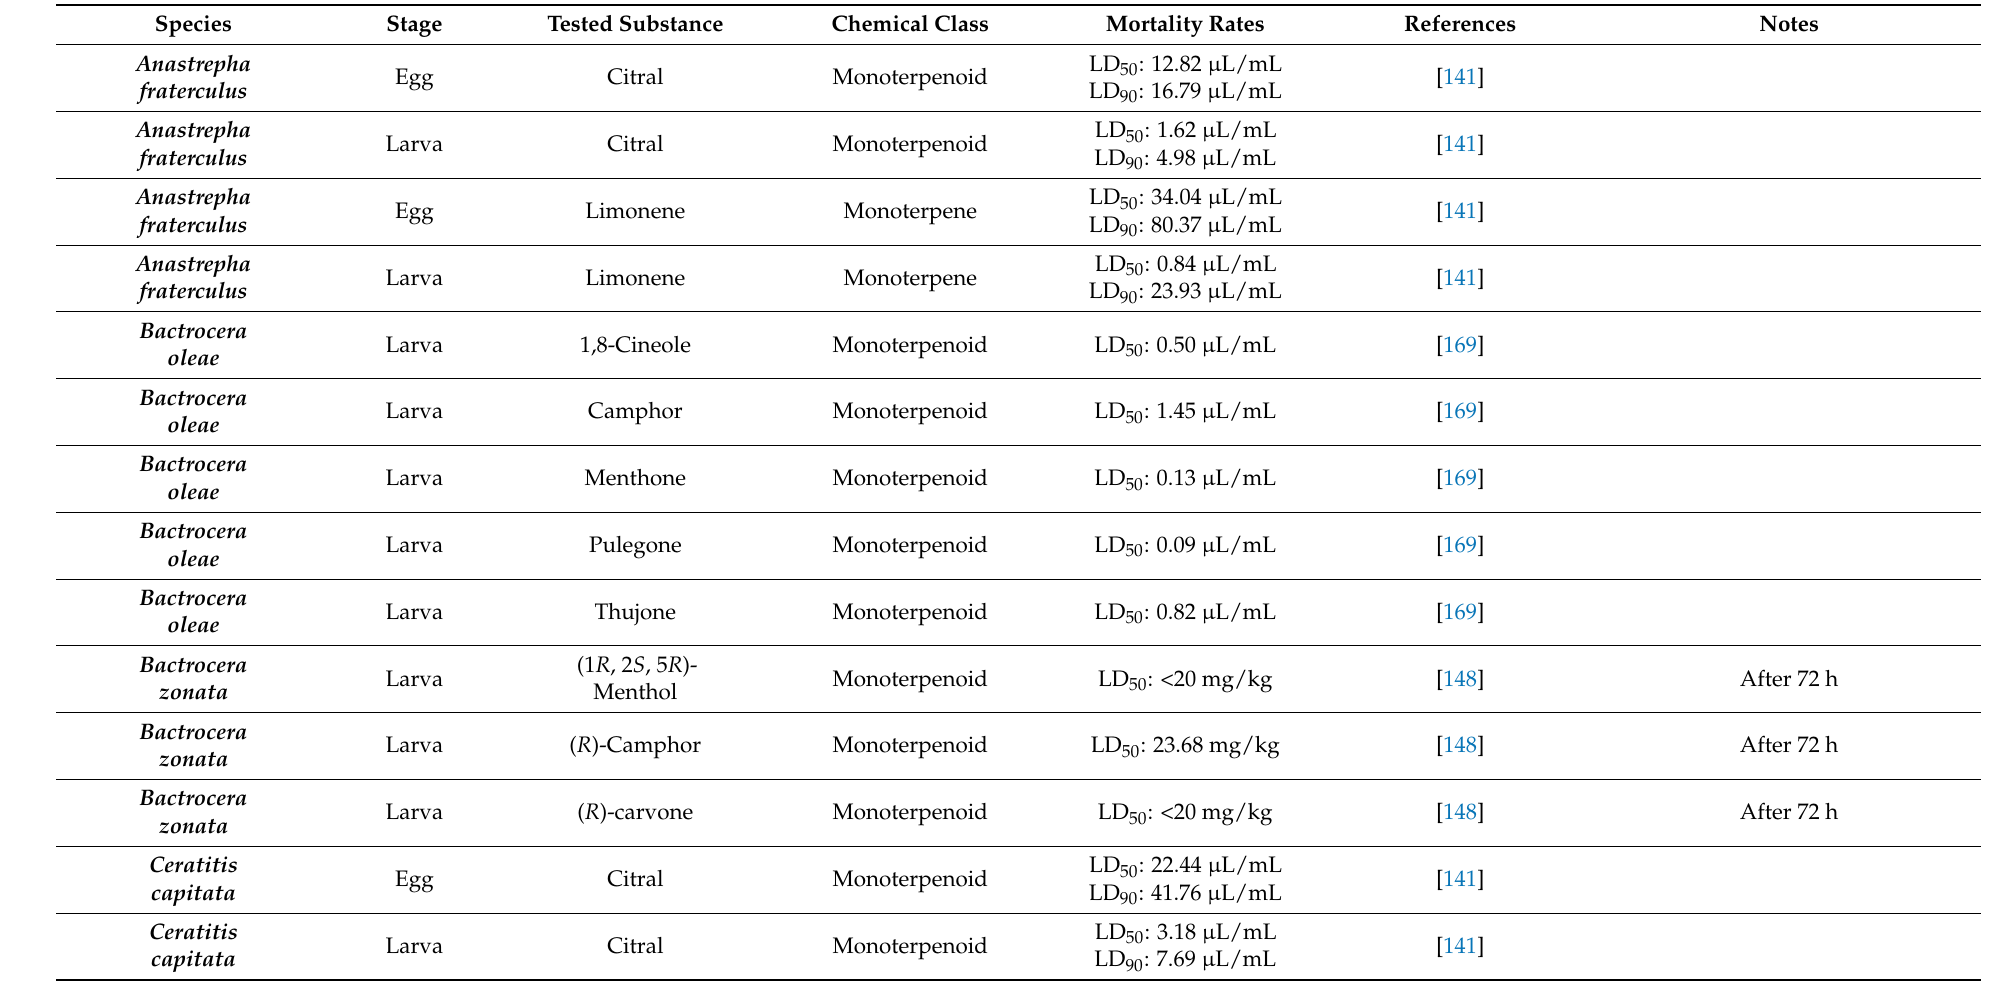
Table 5. Terpenoids and phenylpropanoids were examined for contact action against immature and adult stages of Tephritidae